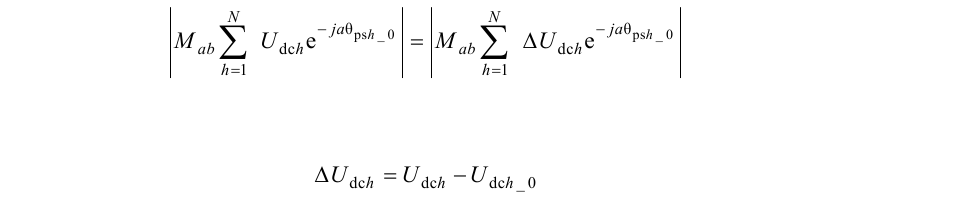
table can be expressed as: U dc h _nor , U dc h_ nor − Δ U dc_inter , U dc h _nor − 2 Δ U dc_inter , ….The symbol U dch_nor denotes the nominal dc voltage of cell h , Δ U dc_inter denotes the difference of the neighbor dc voltage elements listed in the table. In practical, Δ U dc_inter usually interrelates with the upper limit of the sideband harmonic